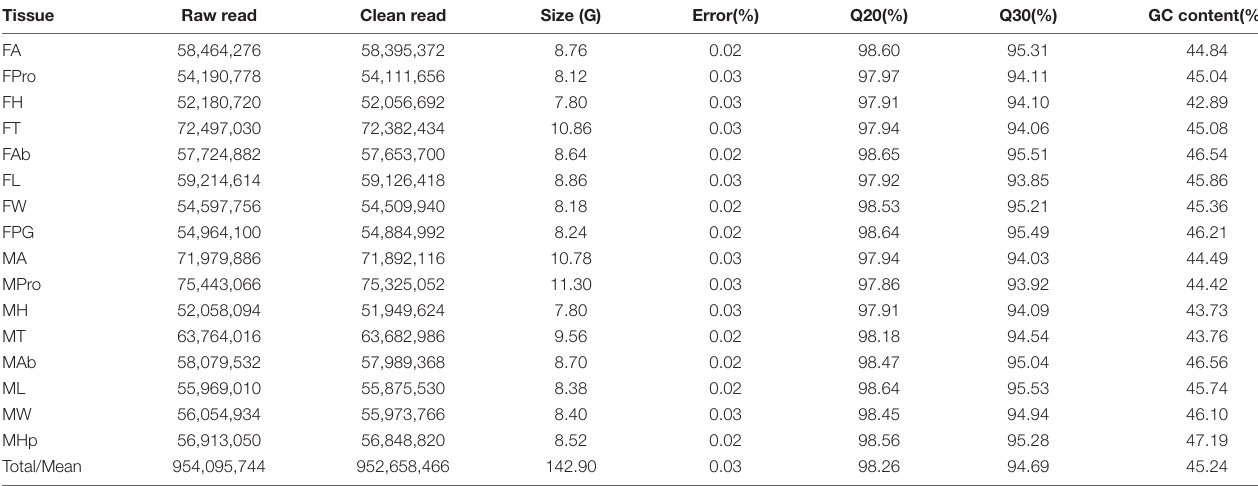
TABLE 1 | Statistics of the transcriptome of various tissues in D. abietella .